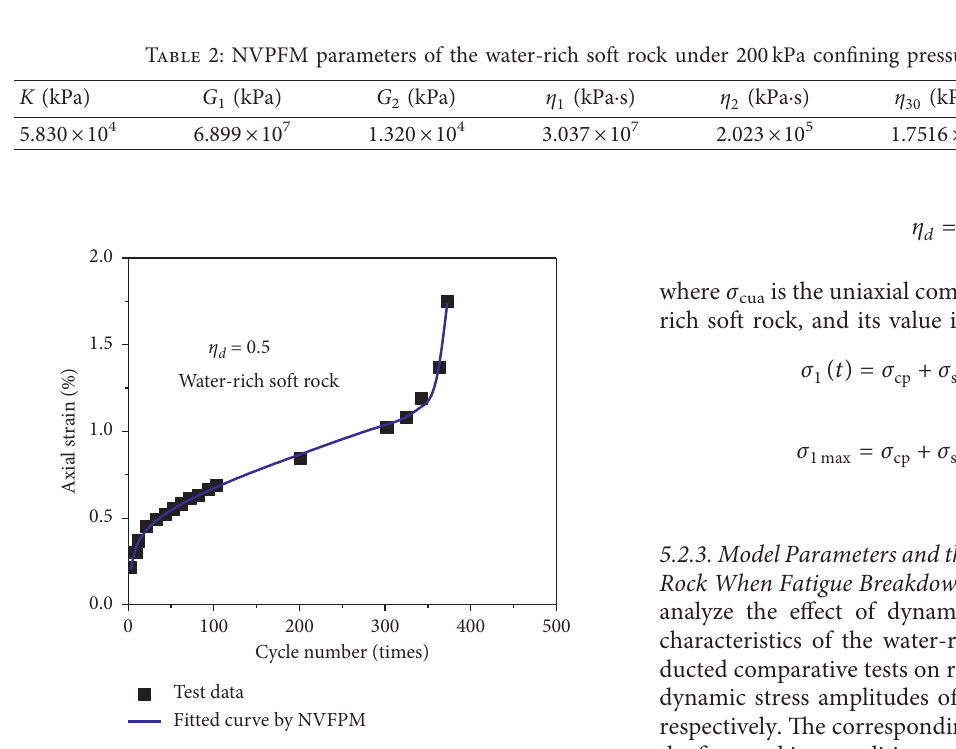
Figure 13: NVPFM curve of the water-rich soft [52] rock under 200kPa confining